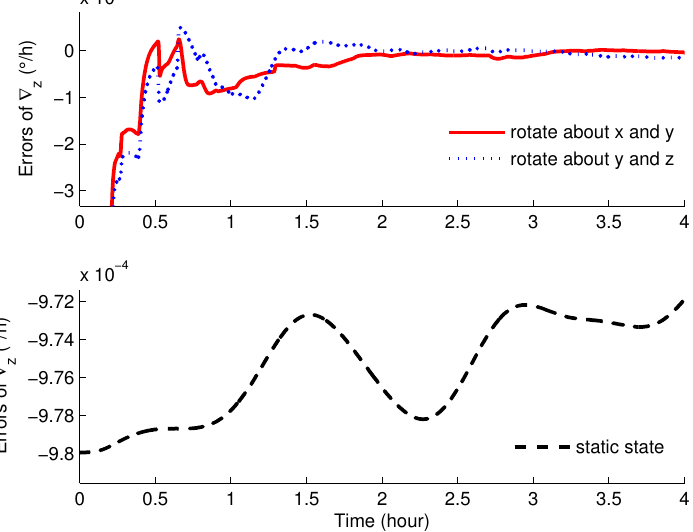
Figure 10. The estimated errors of the azimuth accelerometer biases of the rotation and static